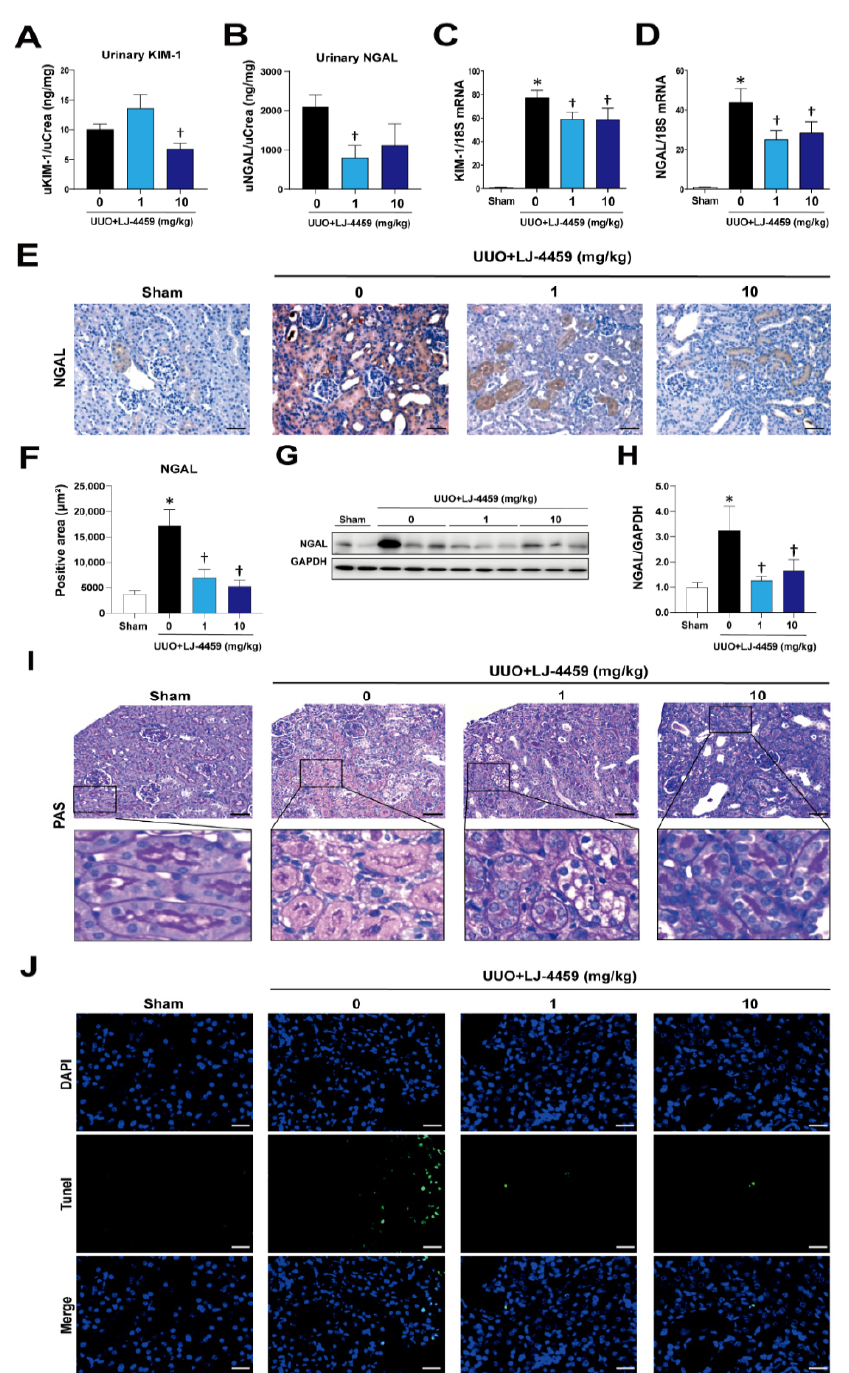
Figure 2. LJ-4459 attenuates kidney tubular injury in UUO mice. Urine was analyzed for ( A ) urinary KIM-1 (ng/mg), and ( B ) urinary NGAL (ng/mg). ( C ) The mRNA levels of KIM-1 were measured. ( D ) The mRNA levels of NGAL were measured. Levels of mRNA were normalized with 18S. Paraffin-embedded kidney sections were stained with ( E , F ) NGAL antibody (1:200; original magnification: 200×; scale bar: 50 μ m). ( G , H ) Immunoblotting analysis of NGAL in the kidney. The levels of proteins were normalized with GAPDH. ( I ) Paraffin-embedded kidney sections were stained with PAS (original magnification: 200×; scale bar: 50 μ m: enlarged images have been shown in the inset). ( J ) TUNEL assay (original magnification: 400×; scale bar: 20 μ m). Data are presented as mean ± SE of 7–8 mice. * p < 0.05 vs. sham mice, † p < 0.05 vs. UUO mice.